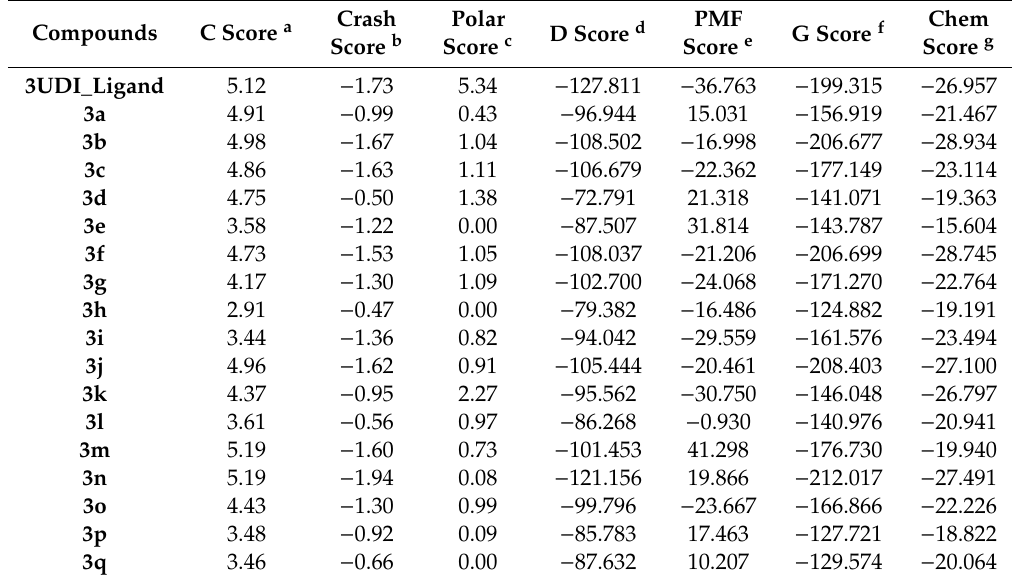
Table 2. Surflex Docking Score (kcal / mol) of the urea derivatives.